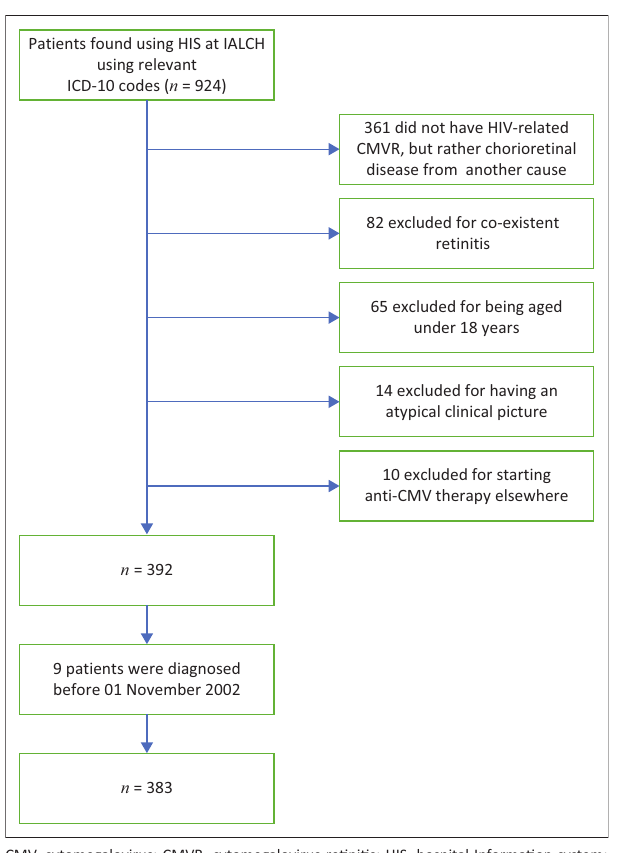
FIGURE 3: Study flow chart showing search and exclusions.